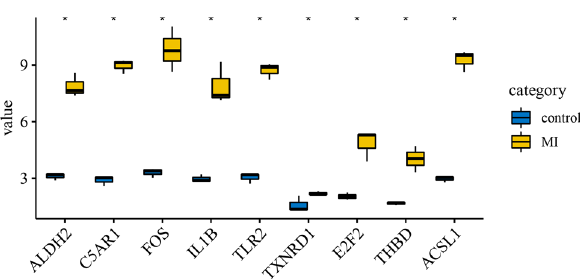
Figure 7. Box plot of expression values of ALDH2, IL1B, TLR2, C5AR1, FOS, THBD, ACSL1, E2F2, TXNRD1 in MI and control samples. *Represents P < 0.05. This figure is drawn by the sangerbox platform (http:// sange rbox. com/